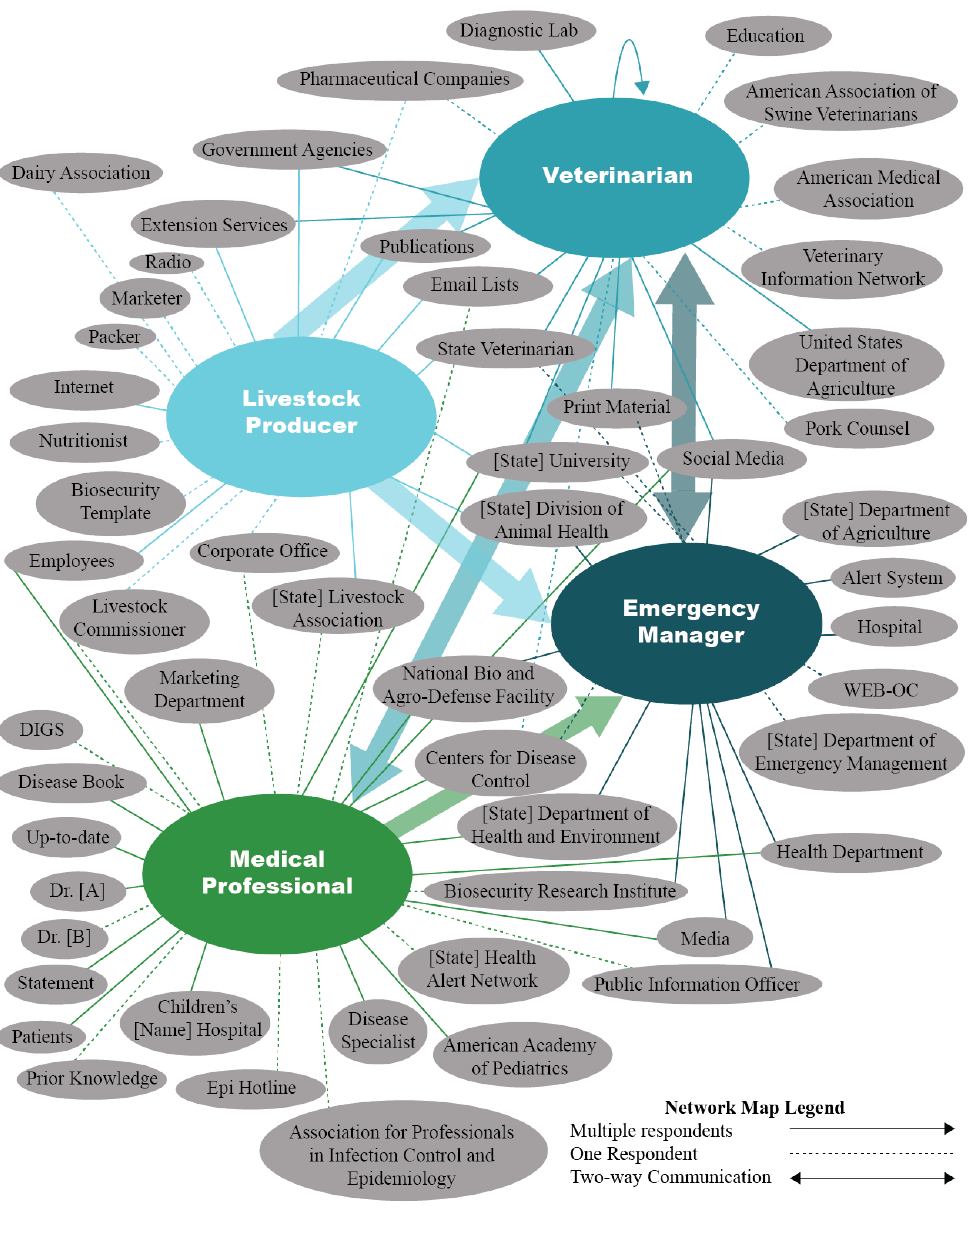
Model of the Social Network Map of livestock producers, veterinarians, human health professionals, and emergency